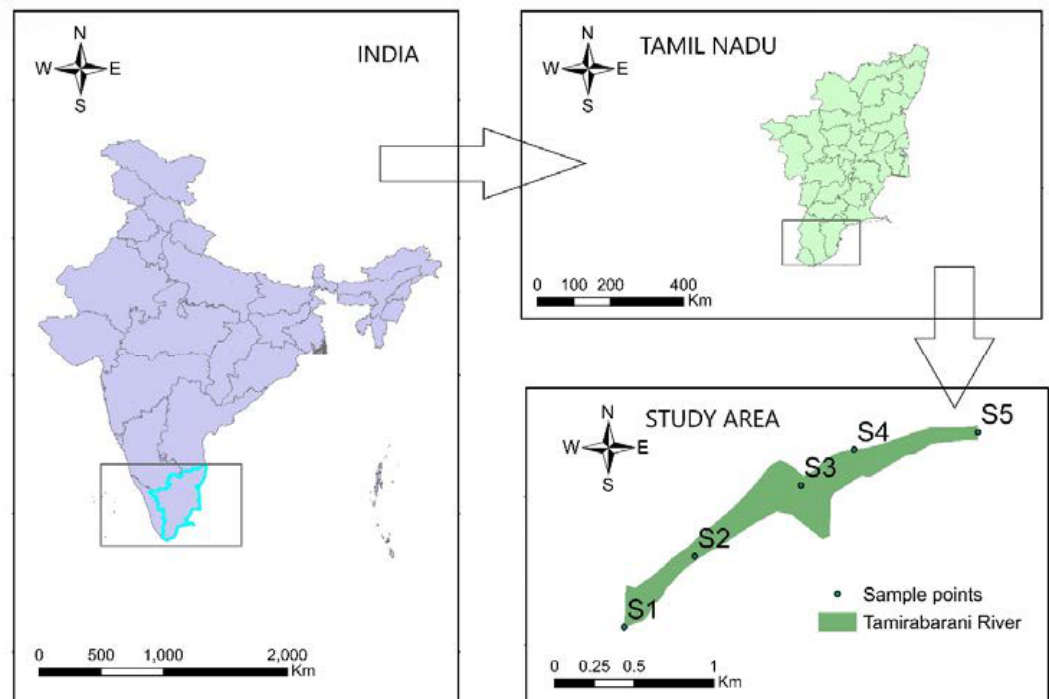
Fig. 1: Geographic location of the study area in the Tamiraparani River in